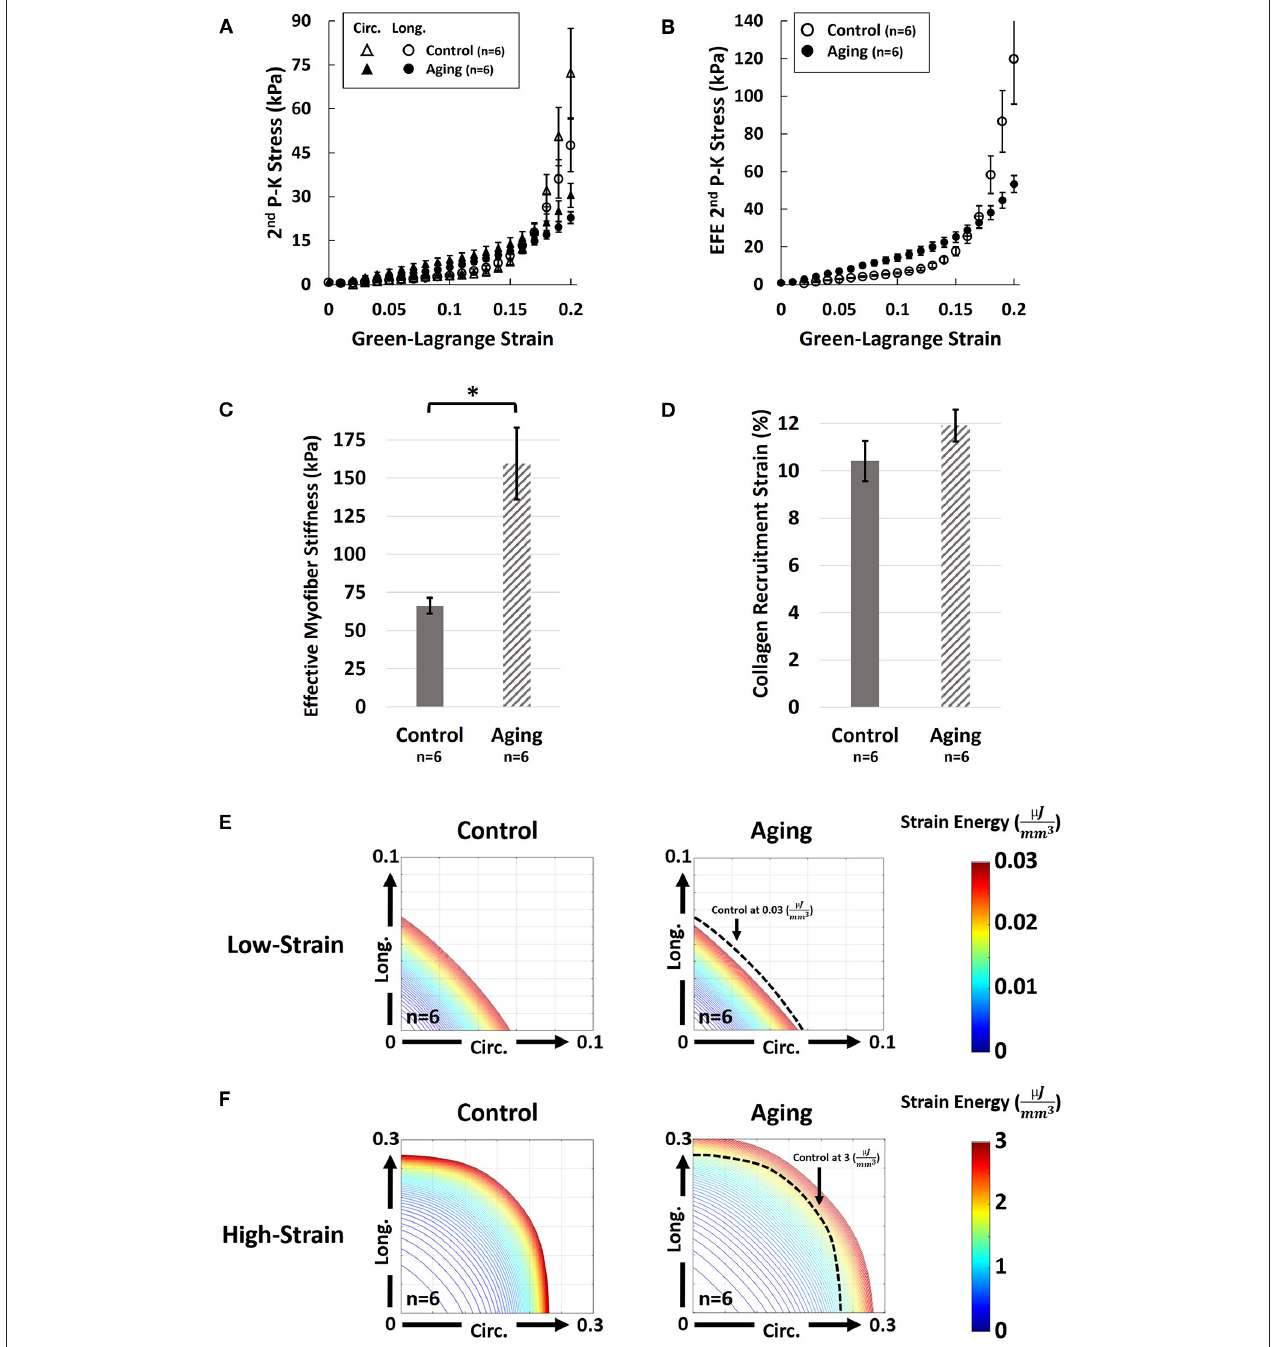
FIGURE 3 | Effects of healthy aging on (A) Biaxial mechanical properties of RV myocardium, (B) Effective fiber-ensemble (EFE) mechanical properties of combined collagen-myofiber bundles, (C) Effective myofiber stiffness, (D) Collagen recruitment strain, (E) Strain energy maps of the RVFW in the low-strain region (circumferential-longitudinal strain space), and (F) Strain energy maps of the RVFW in the high-strain region. Healthy aging modulates the biomechanical properties of the RVFW in a bimodal manner by resulting in increased circumferential and longitudinal stiffness under lower strains, while progressing to decreased biaxial stiffness at higher strains. Significant myofiber stiffening was observed with healthy aging. Specimens in the aging cohort demonstrate higher levels of strain energy at equivalent levels of deformation compared to controls in the low strain region (indicating RVFW stiffening), while showing lower strain energy in the high-strain region (indicating a more compliant RVFW). Error bars represent standard error of the mean (SEM).*Indicates p < 0.05. RV, Right ventricle; RVFW, Right ventricular free wall; 2nd P-K Stress, 2nd Piola-Kirchhoff stress; Circ, Circumferential; Long, Longitudinal; EFE 2nd P-K Stress, Effective fiber-ensemble 2nd Piola-Kirchhoff stress.